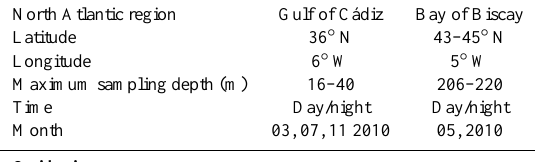
Table 5. Bongo net data set. List of jellyfish taxa collected in epipelagic waters (0–200m or 0–bottom) in 2010, in the Gulf of Cádiz and Bay of Biscay. Data from Licandro et al.